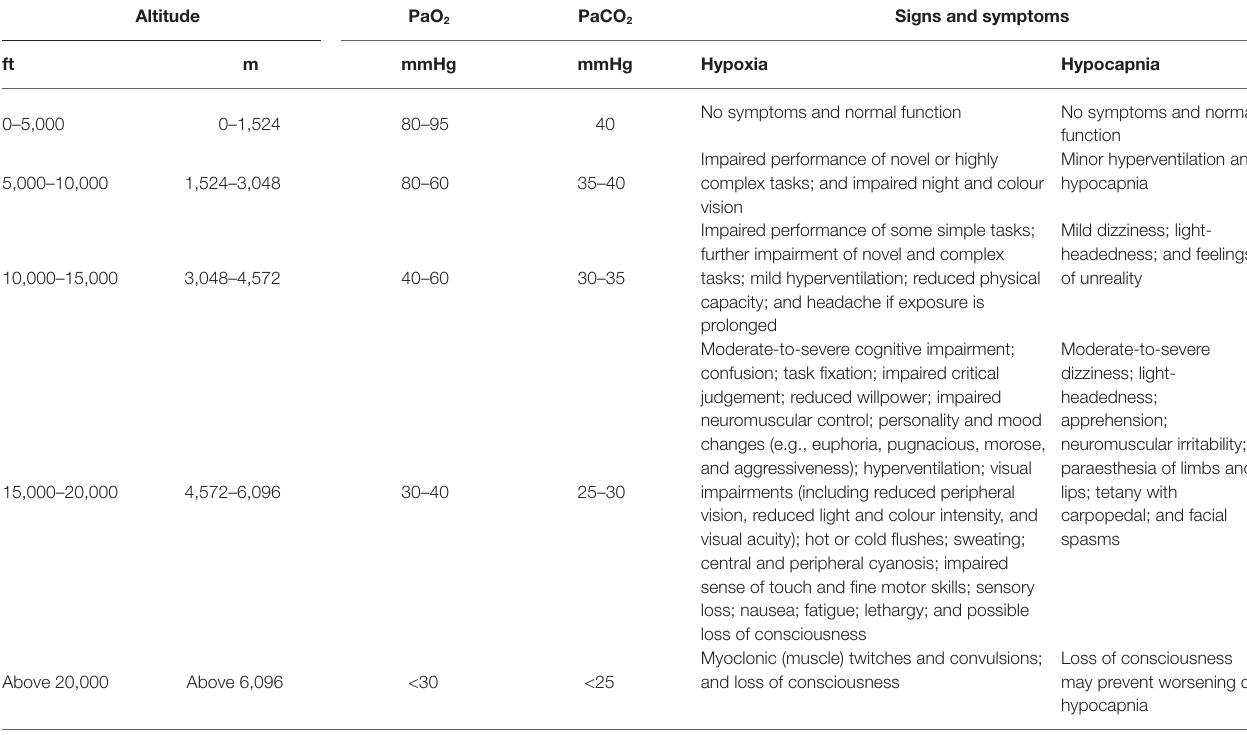
TABLE 1 | Functional impairment and clinical status during hypoxia and hyperventilation-induced hypocapnia whilst sedentary at altitude. Altitude PaO 2 PaCO 2 Signs and